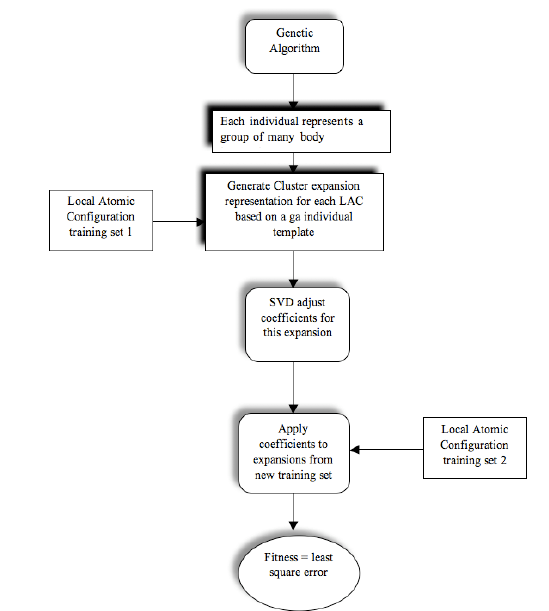
Fig. 8. GA based Cluster Expansion optimization. Fig. 9. Cluster expansion VME predictions for